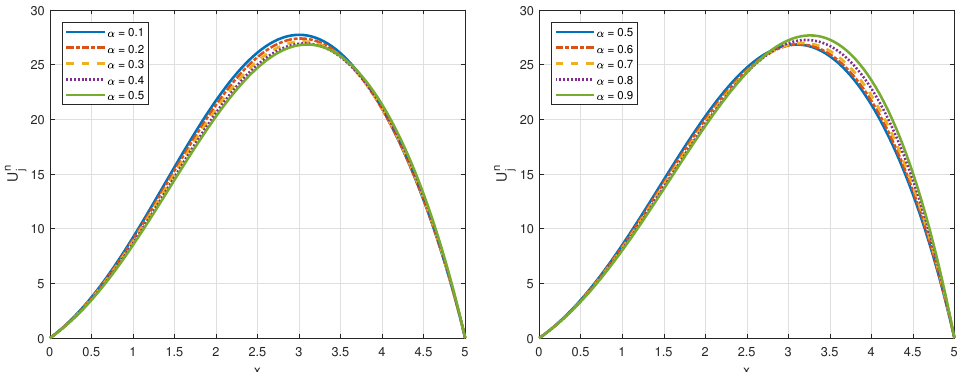
Figure 5. Numerical solutions of the FPDE (25) for different values of α with N = J =